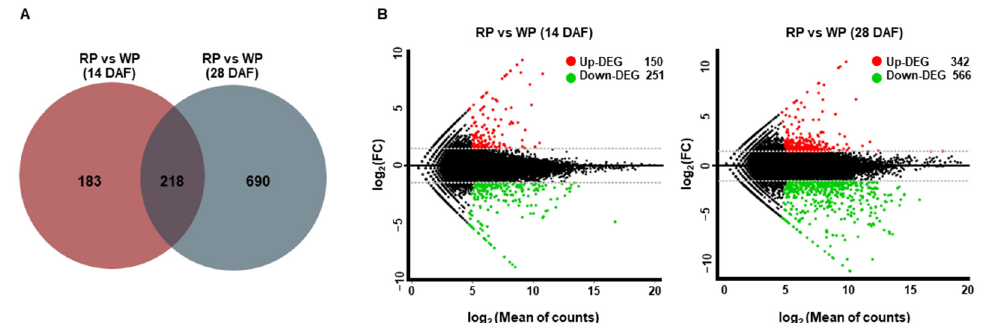
Figure 2. Differentially expressed genes (DEGs) between the seeds of red pericarp (RP) and white pericarp (WP) rice. Venn diagram ( A ) and MA plot ( B ) showing the number of DEGs between RP and WP rice at different seed developmental stages. Red and green dots represent significantly upregulated and downregulated genes, respectively; black dots represent genes with no significant difference.